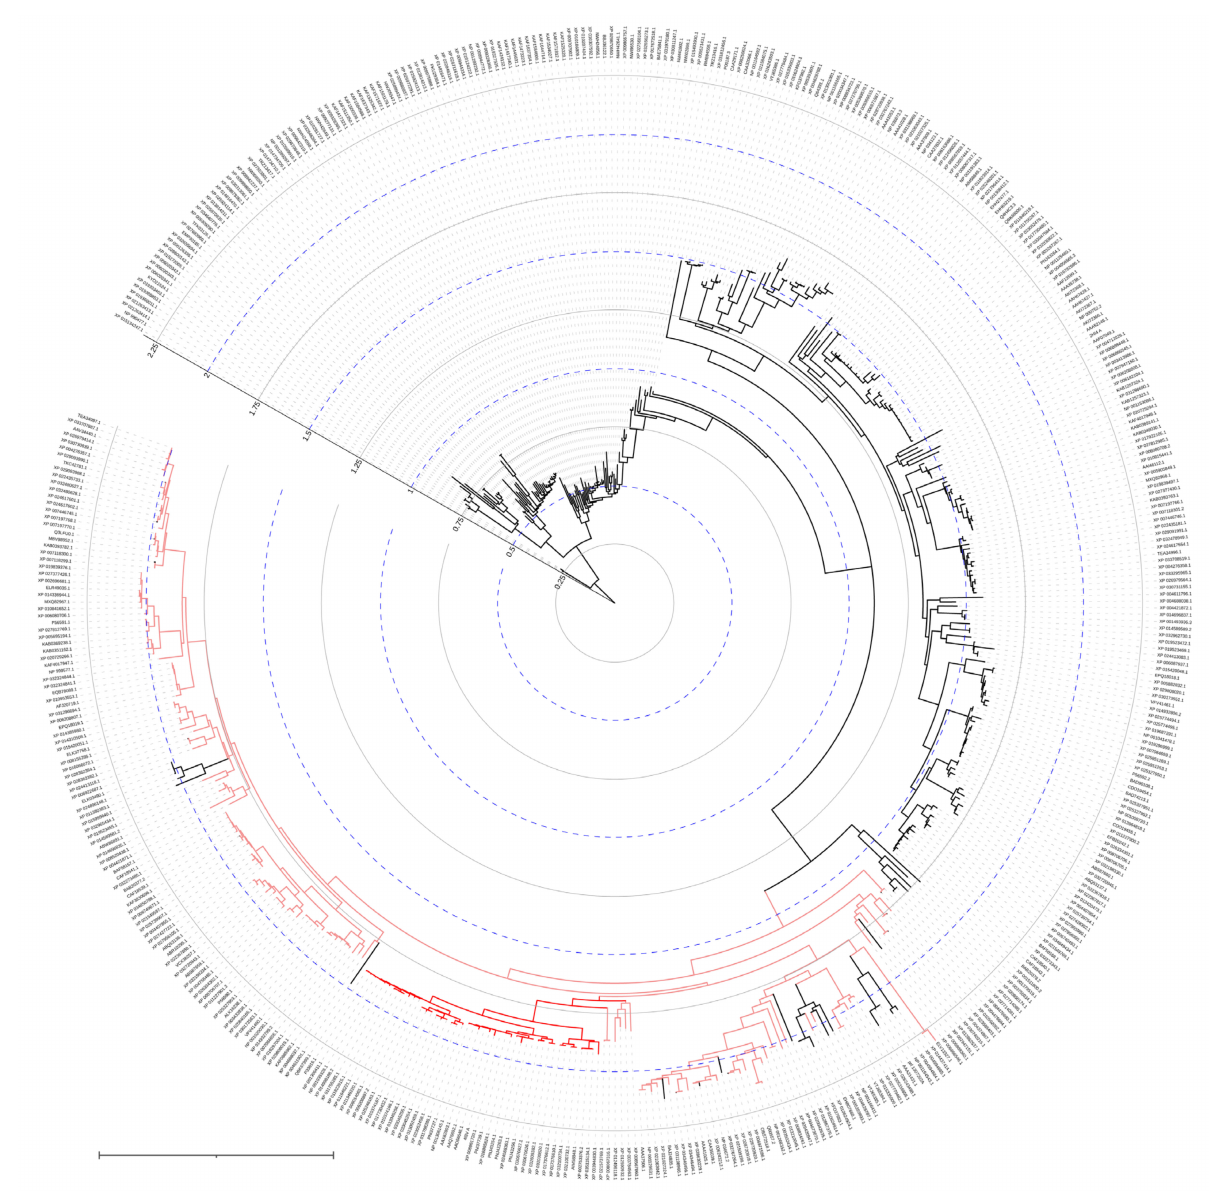
Figure 15. Phylogenetic tree of CYP1A1 and its homologous enzymes (down to 63% identity). The tree was built as previously with PDB 4I8V as a reference sequence. Enzymes having high (90–100%) and good (80–89%) identity are highlighted with red and pink,